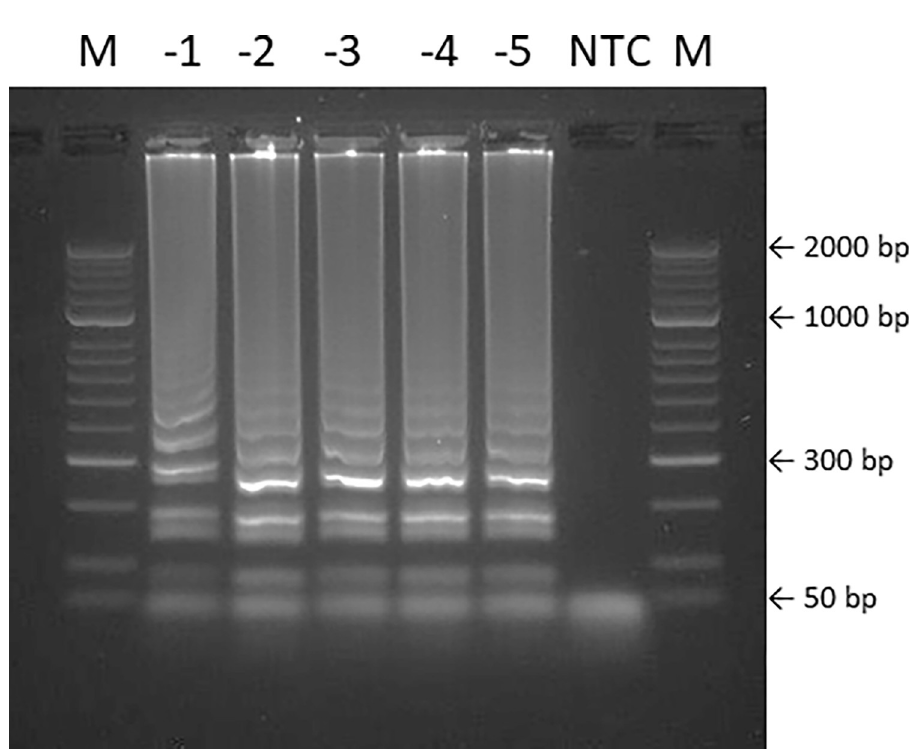
Fig 4. Confirmation of the specificity of LAMP products obtained from 10-fold serially diluted tuna DNA samples using gel electrophoresis. All samples showed an identical ladder-like band profile.